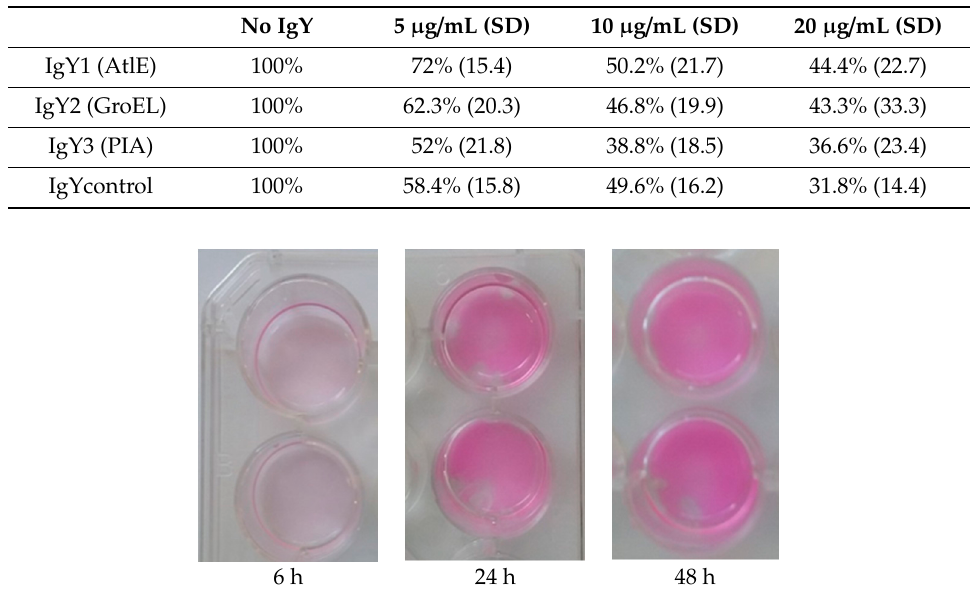
Figure 1. Staining of Staphylococcus epidermidis biofilms with Mira-2-ton after 6, 24 and 48 h. Bacteria were adjusted to a concentration of 3 × 10 6 / 2 mL and incubated at 37 ◦ C, shaking at 60 rpm.